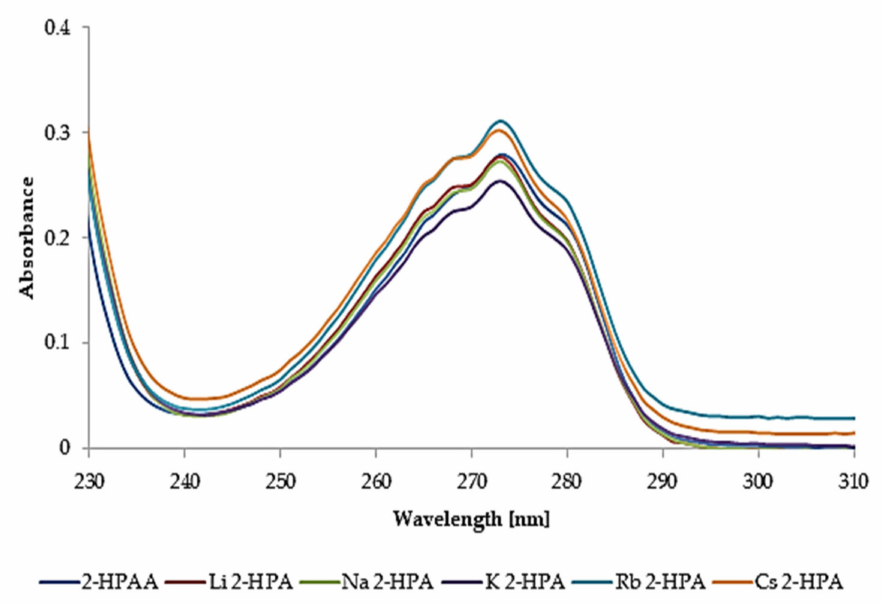
Figure 3. The UV spectra of the 2-HPAA and its alkali metal salts in methanol (0.1 mM). The values of the proton 1 H NMR and carbon 13 C NMR chemical shifts were summa- rized in Table S1. The proton spectrum of 2-hydroxyphenylacetic acid (Figure S2) showed: four signals located in the range of 6.76–7.12 ppm were assigned to the aromatic protons, a single signal derived from the aliphatic protons (CH 2 group) (located at the 3.53 ppm), and signals assigned to the protons of hydroxyl groups: signal located at 9.44 ppm assigned to the -OH group of the carboxylic group, and the signal located at 12.13 ppm assigned to the proton of the hydroxyl group attached to the aromatic ring. The signal from the proton of the hydroxyl group of the aromatic ring is shifted downfield (above 12 ppm) due to the presence of hydrogen interactions of the hydroxyl group with the carbonyl atom in the acid and salts. On the FTIR spectra, bands of the hydroxyl group (aromatic ring) were observed below 3500 cm − 1 , which may indicate that the proton of this group forms hydrogen